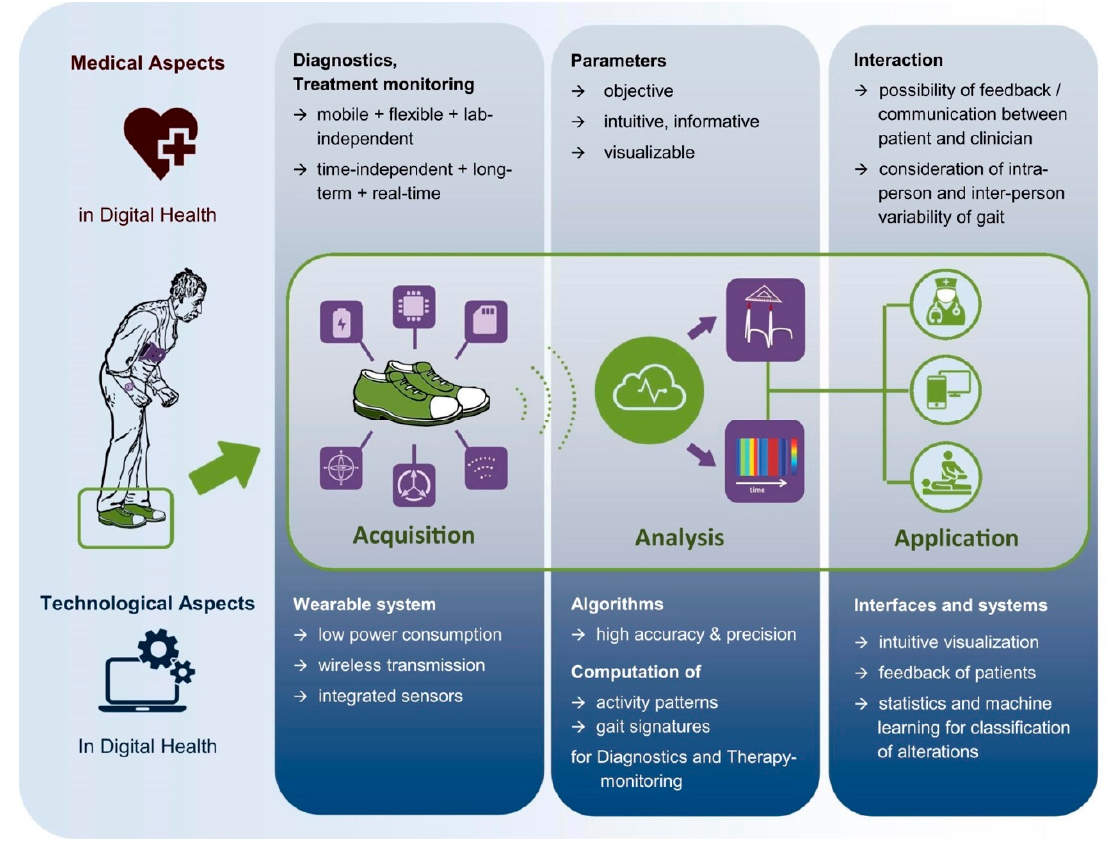
Figure 2. Medical and technological requirements for Internet of Health Things (IoHT) for ambulatory gait monitoring. Icons modified and printed with permission of [3–5]. Patient figure adapted from [6].